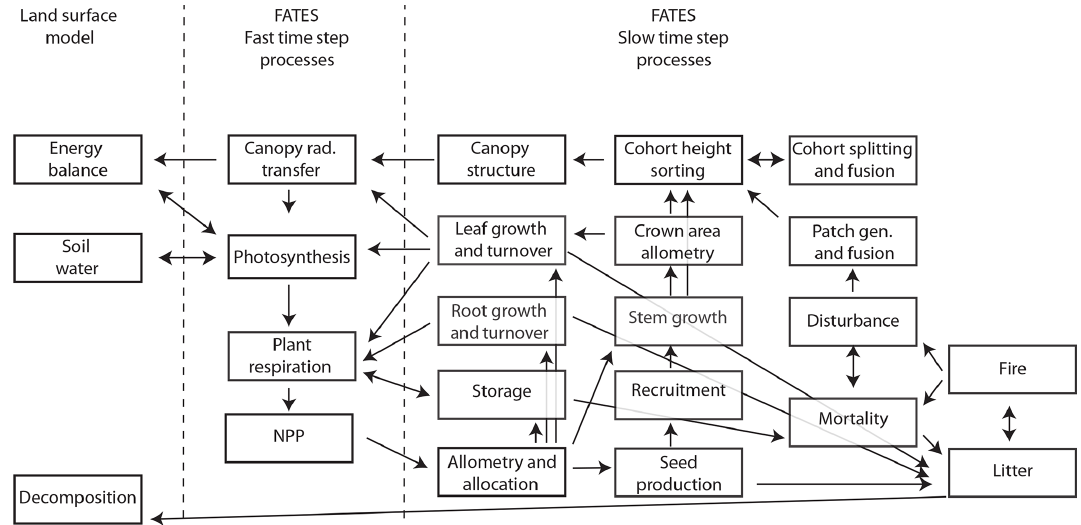
Figure 1. Overall process schematic of FATES. Boxes represent major processes, and arrows represent linkages in the form of material flows or other dependencies. Fast time step processes are resolved every 30min, and slow time step processes are resolved